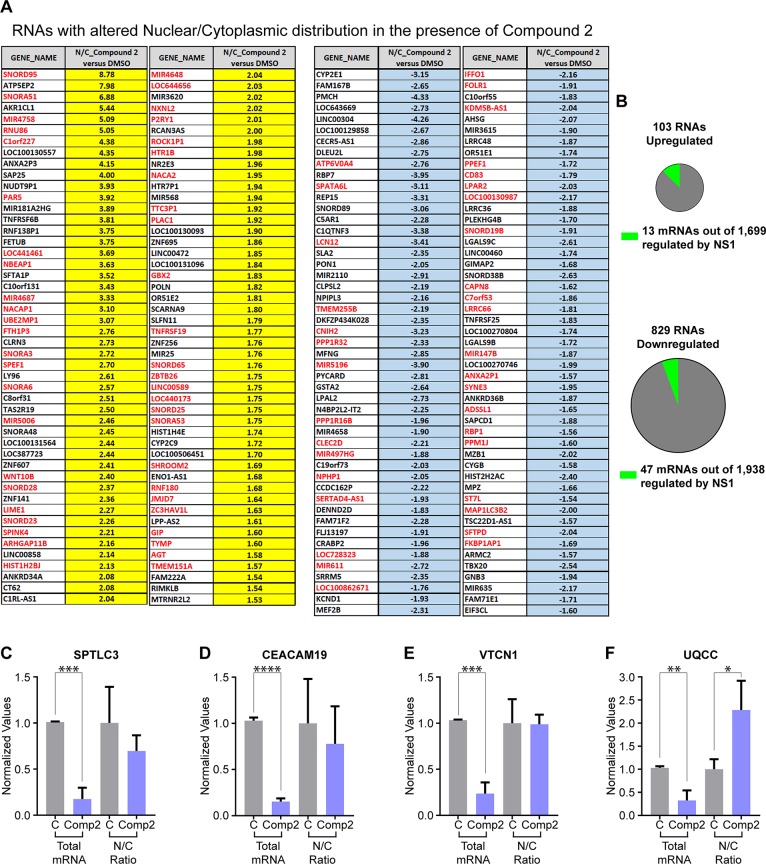
Compound 2 alters the levels and intracellular distribution of a subset of cellular mRNAs.Poly(A) RNA from total cell lysates, nuclear and cytoplasmic fractions untreated or treated with compound 2 was subjected to RNAseq analysis. Two biological duplicates were analyzed and the cut off is 1.5 fold for all analysis. RNAs selected were hits in both samples. (A) RNAs that are nuclear retained (yellow) or preferentially exported to the cytoplasm (light blue) are shown. Marked in red are RNAs whose total levels were not altered. Controls for fractionation are shown in S1 Table. (B) The number of RNAs that are up-regulated or down-regulated by compound 2 are shown. Marked in green are the number of RNAs known to be regulated by NS1 during infection. The identity of these RNAs are shown in S1 Table. (C-F) Selected mRNAs were also analyzed by qPCR to corroborate the RNAseq analysis. Relative mRNA levels and nuclear to cytoplasmic ratios of SPTLC3 (D), CEACAM19 (E), VTCN1 (F), and UQCC (G) were determined by qPCR from RNA obtained from total cell lysates, nuclear and cytoplasmic fractions treated with 0.1% DMSO or 2.5 μM compound 2 for 9 h. Three independent experiments were performed. C, control; Comp 2, Compound 2. Graphs show mean +/- SD. *p<0.05, **p<0.01, ***p<0.001 ****p<0.0001.